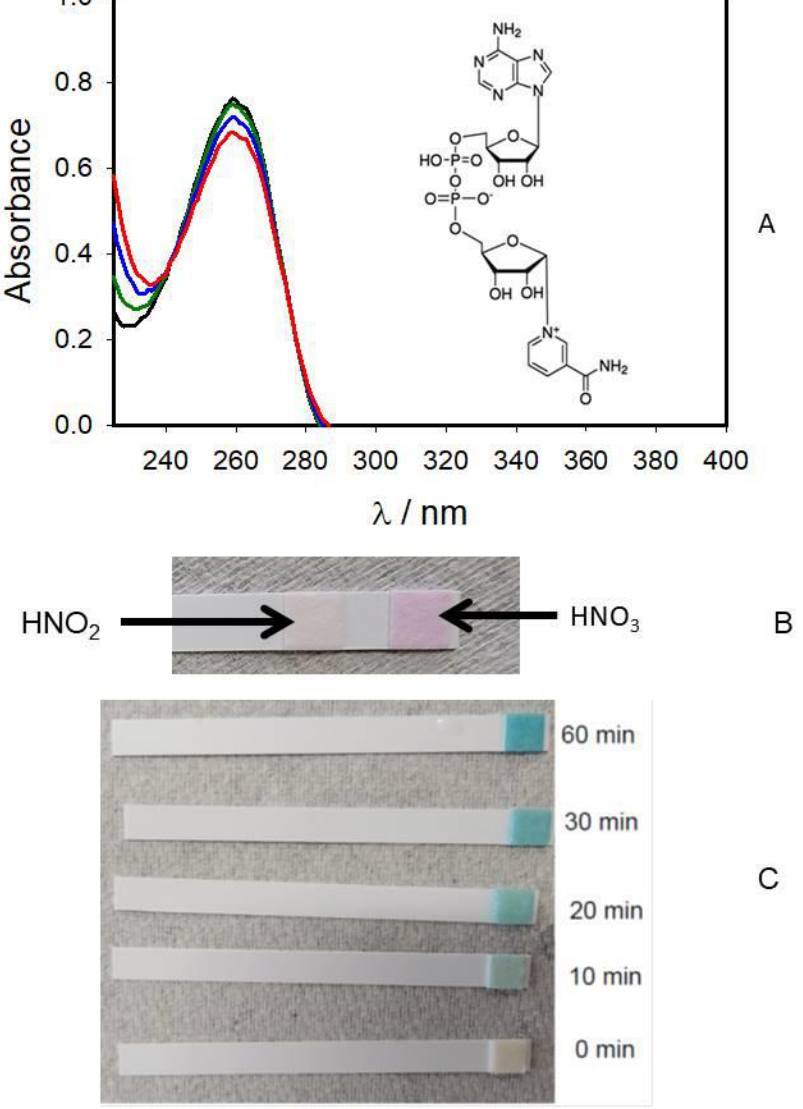
Figure 3. ( A ) Absorption spectra of 50 µ M NAD + aqueous solution before (black) and after the treatment with cold atmospheric pressure He-plasma jet for 10 min (green), 30 min (blue), and 60 min (red). ( B ) Testing with nitrate ( ≈ 0.2 mM) and nitrite ( ≈ 0.01 mM) white test strips the production of HNO 3 and HNO 2 after 60 min treatment of 50 µ M NAD + aqueous solution with cold atmospheric pressure He-plasma jet. ( C ) Detection with test strips H 2 O 2 production during the treatment of 50 µ M NAD + aqueous solution with cold atmospheric pressure He-plasma jet. The test strips acquire specific color only in the presence of specific substrates, such as HNO 3 and HNO 2 ( B ) or H 2 O 2 ( C ). The temperature was 20 °C .